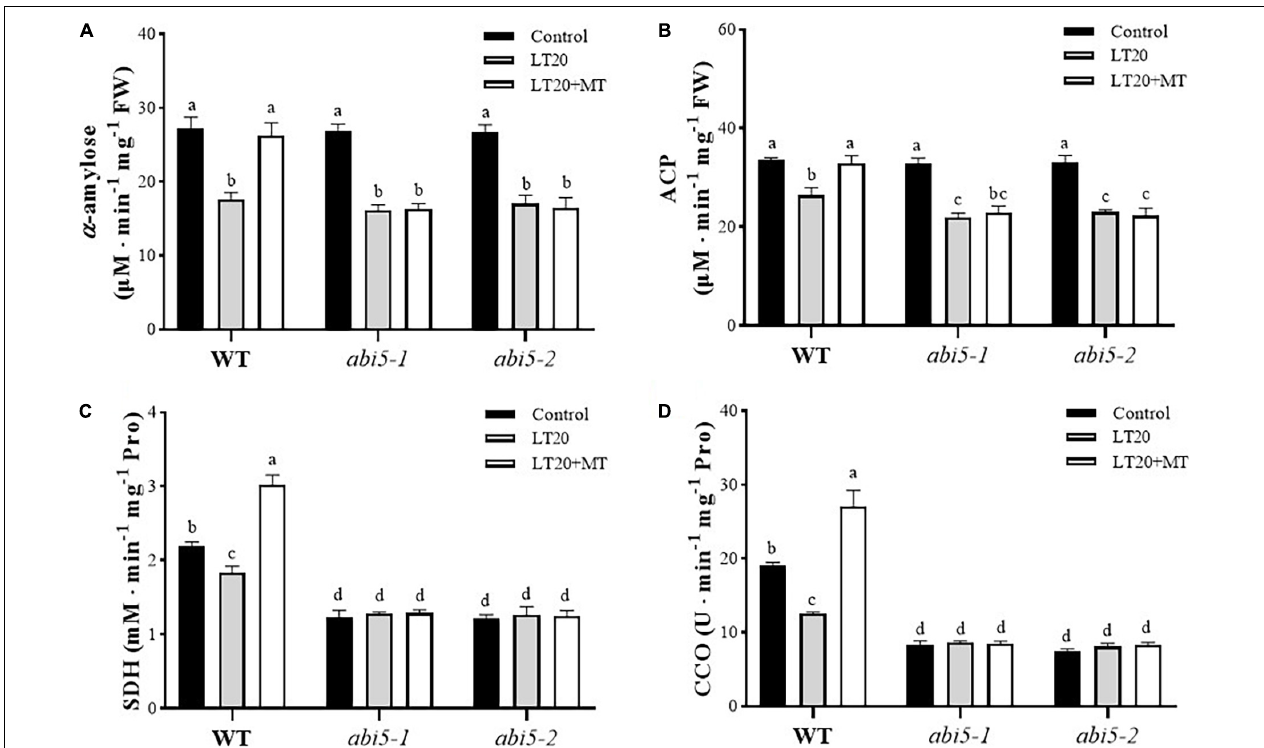
FIGURE 4 | Effects of exogenous MT treatment on seed germination associated with enzymes under LT stress. Activities of (A) α -amylase, (B) acid phosphatase (ACP), (C) succinic dehydrogenase (SDH), and (D) cytochrome oxidase (CCO) under LT stress (constant 20 ◦ C for 7 days) without (LT20) or with MT (LT20 + MT) treatment. Different letters denote significant variations between the treatments, and the average values were measured by Tukey’s HSD test at p < 0.05. Data were represented as mean ± SE of six biological